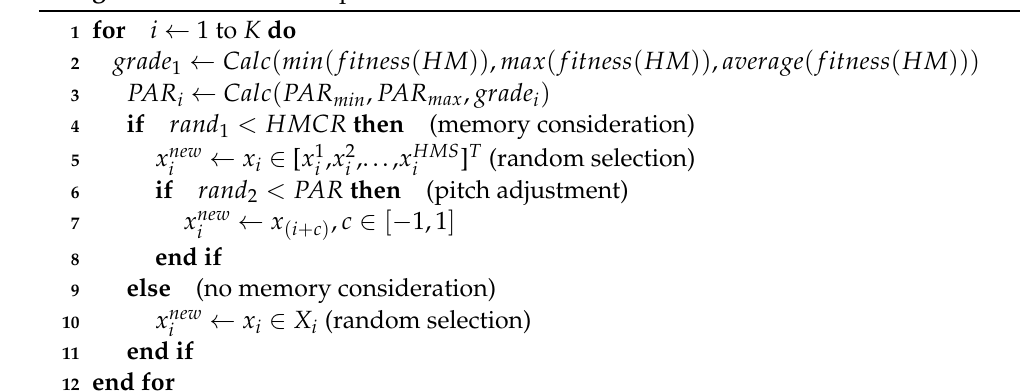
Algorithm 2: IHS search process for new solutions.